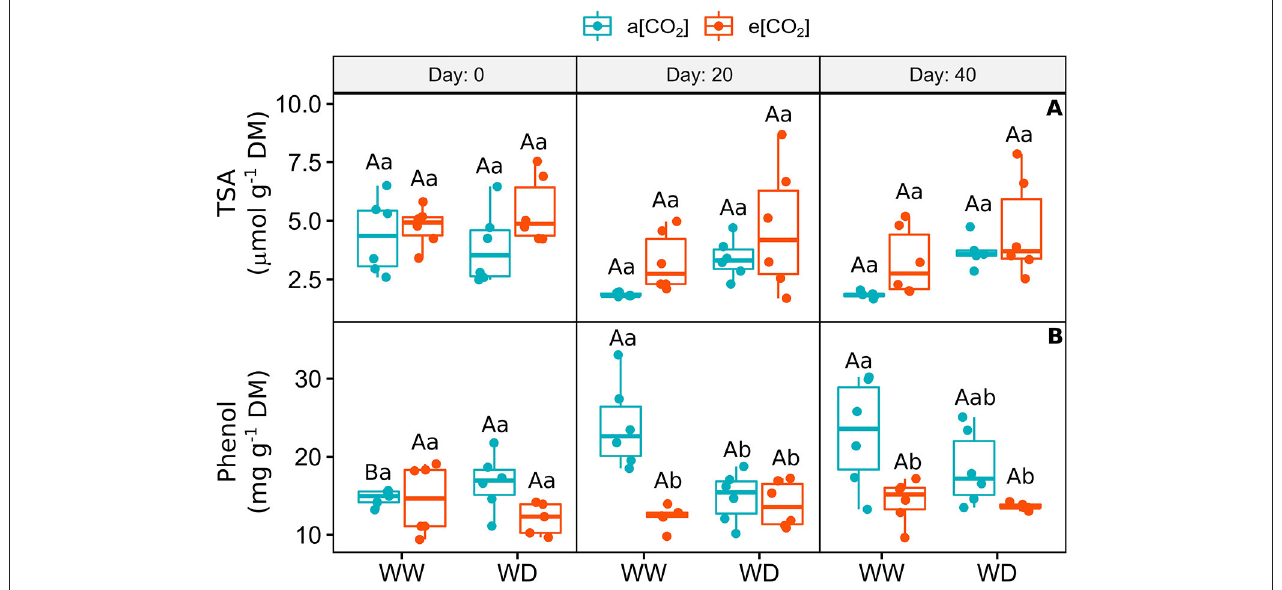
FIGURE 4 | (A) Content of total soluble amino acids and (B) Total phenolic compounds in leaves of C. arabica plants exposed to ambient [CO 2 ] under well-watered and water deficit (a[CO 2 ] + WW and a[CO 2 ] + WD, respectively) and elevated [CO 2 ] under well-watered and water deficit (e[CO 2 ] + WW and e[CO 2 ] + WD, respectively) conditions on day 0, 20, and 40 after water deficit imposition in the OTC. Boxes represent the median and first and third quartiles, symbols represent individual samples ( n = 6–5 biological replicates). Different capital letters represent significant differences between sampling day in the same water and [CO 2 ] condition, whereas different lowercase letters represent significant differences between water and [CO 2 ] conditions in the same sampling day according to Tukey’s test at 5% of probability ( P ≤ 0.05).